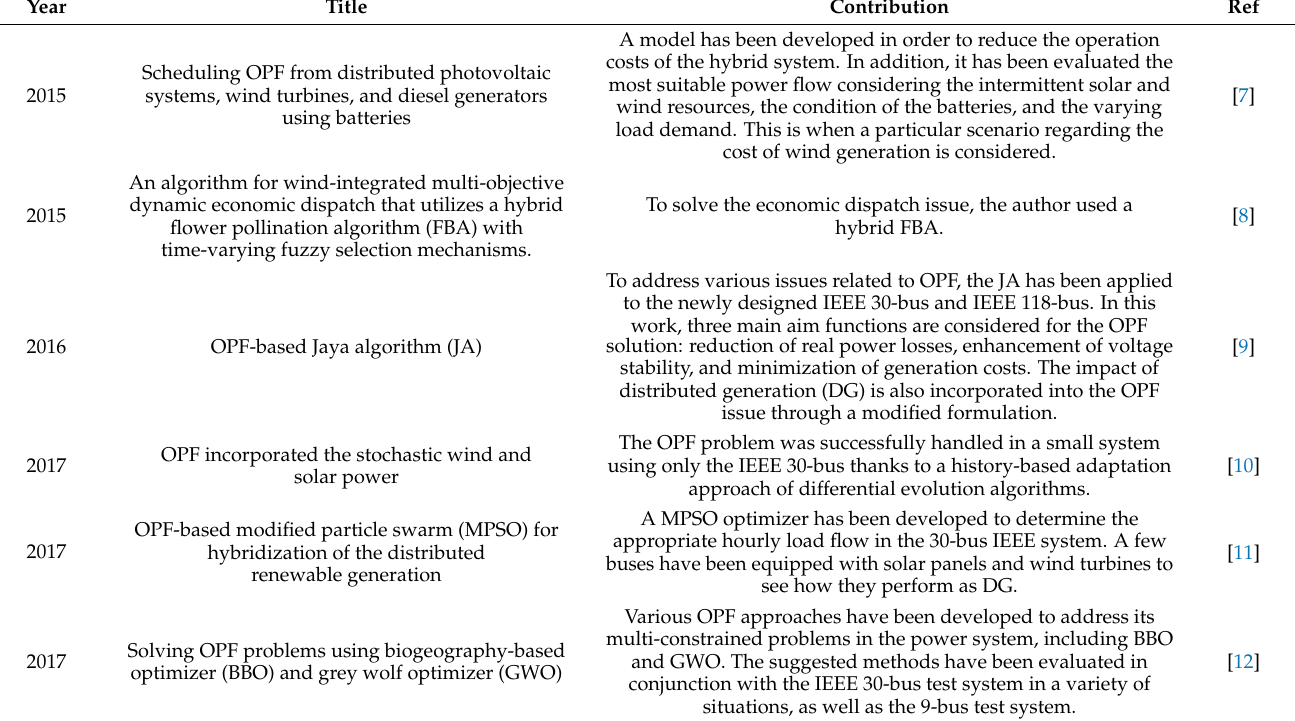
Table 1. Applied techniques for the optimal power flow (OPF)